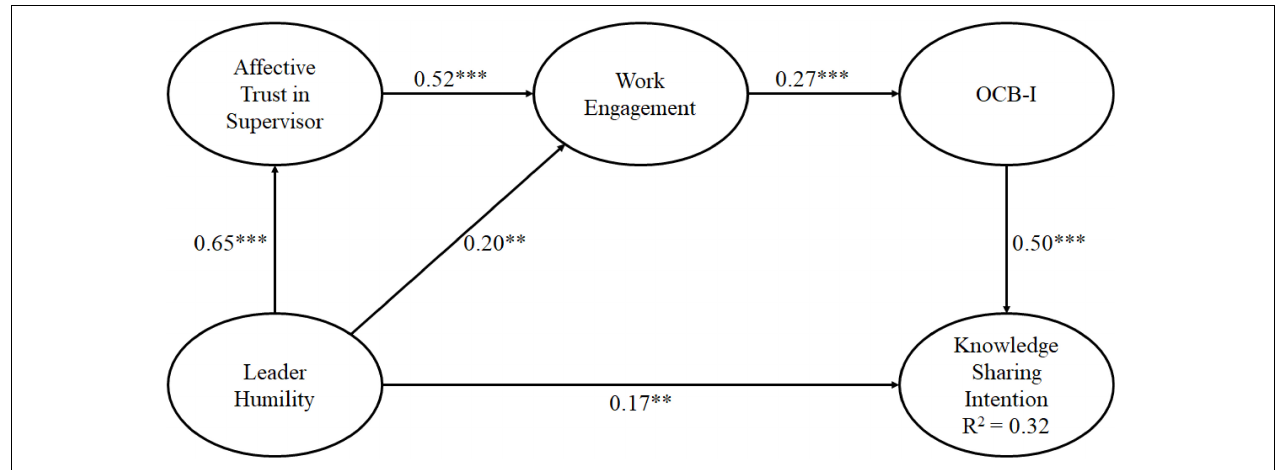
FIGURE 2 | Significant results of direct relationships of proposed variables. Straight lines demonstrate direct effects. ∗∗ p < 0 . 01, ∗∗∗ p < 0 .